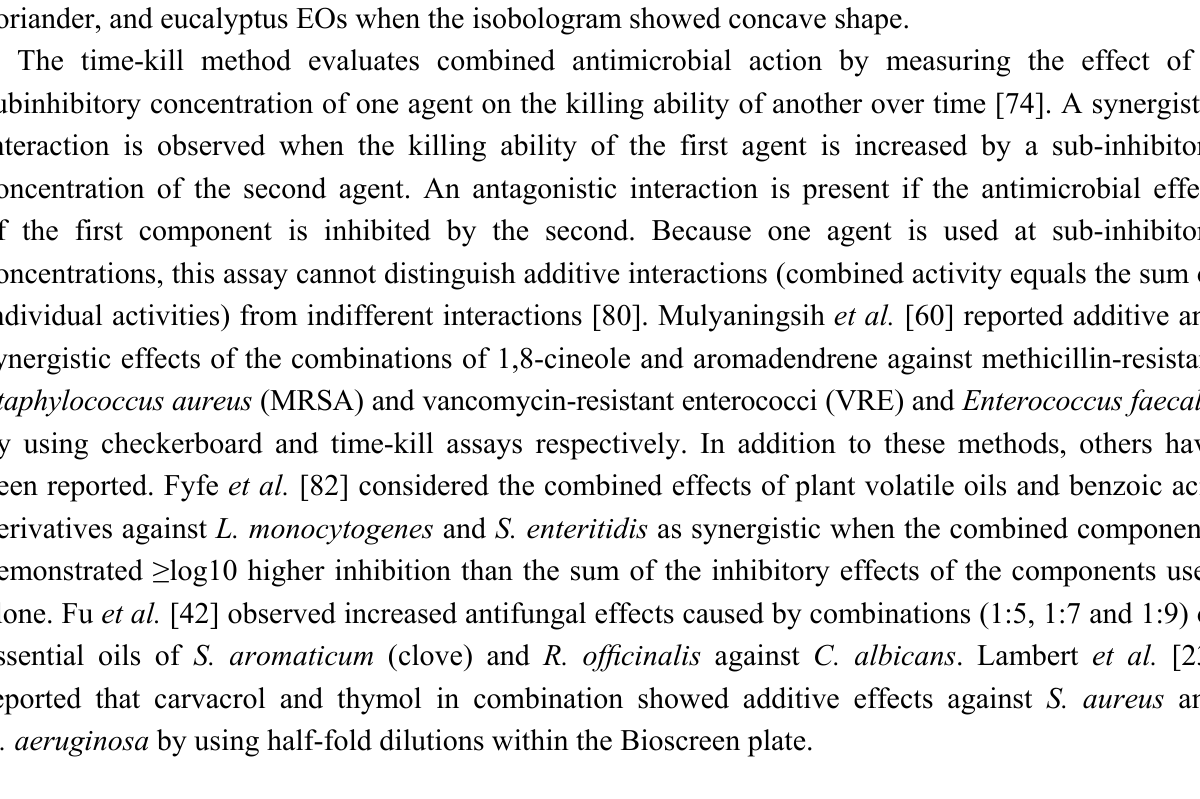
Table 3. Ratio of combined compounds and percentage of effective reduction concentration by synergy as compared with the individual